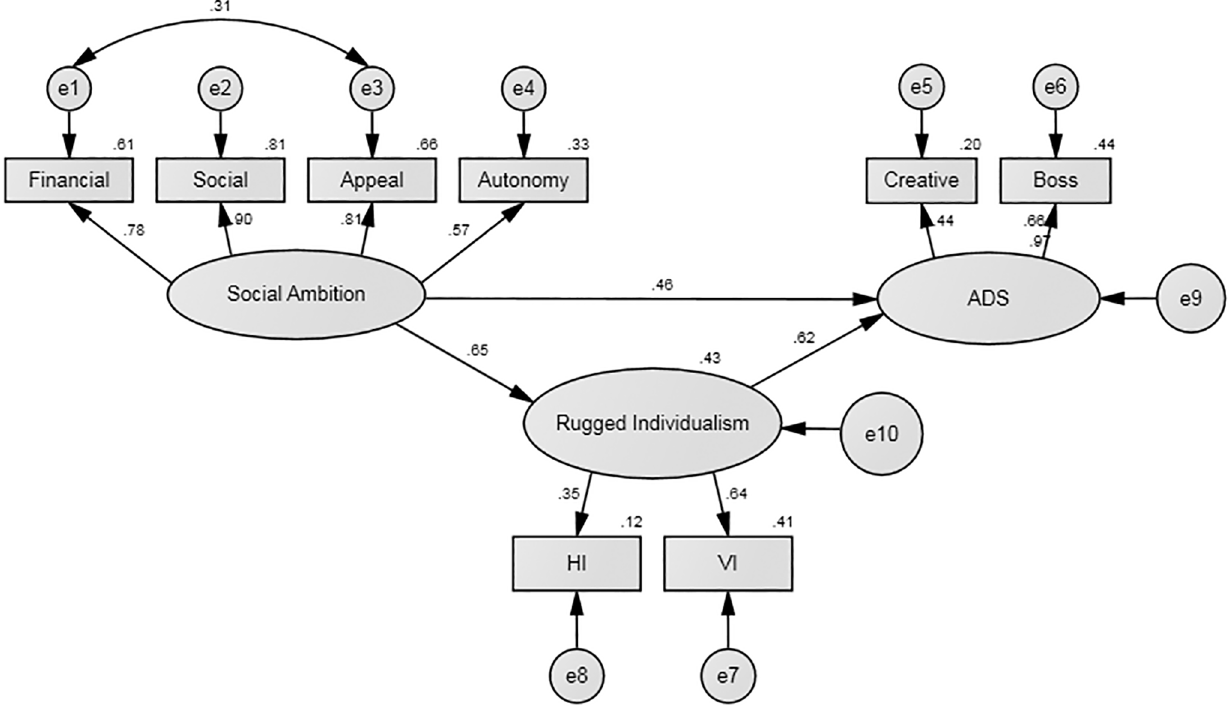
Figure 2. Structural model predicting ADS construct. Latent constructs are shown in ellipses, and observed variables are shown in